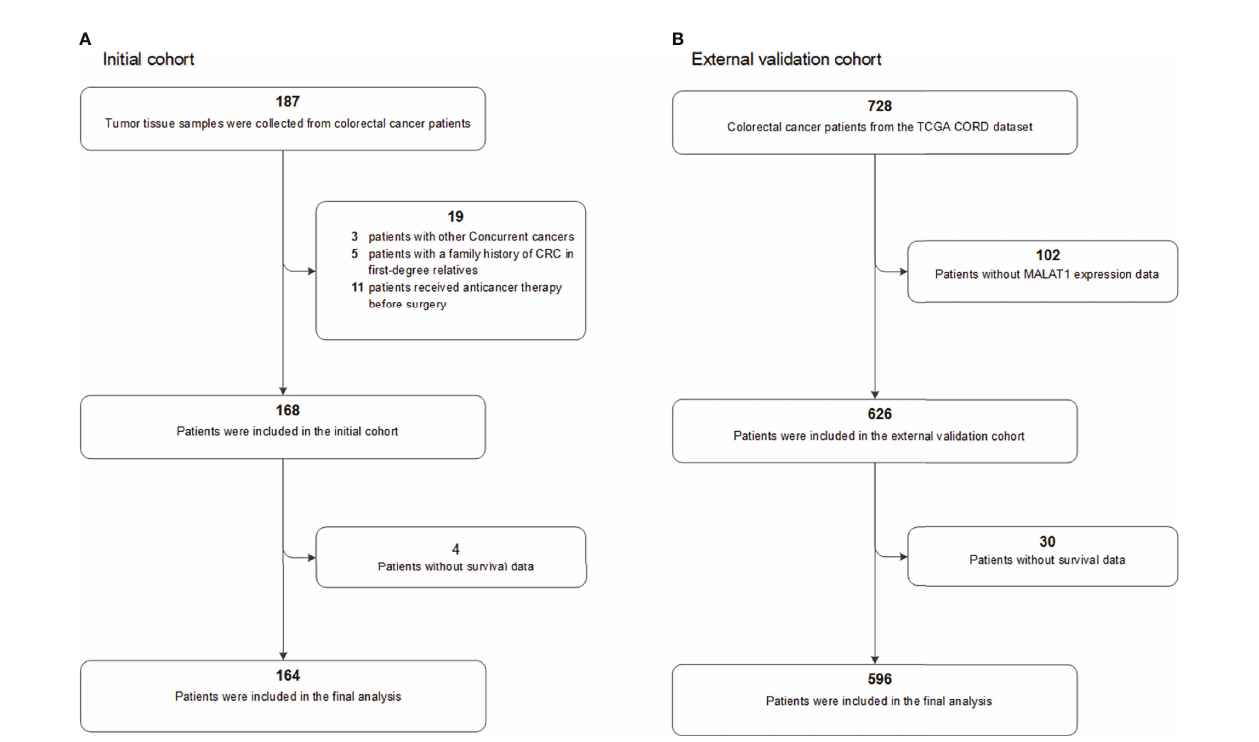
FIGURE 1 | Flow chart of participants included and analysed in the (A) initial and (B) external validation cohorts. COAD, colon adenocarcinoma; CRC, colorectal cancer; TCGA, The Cancer Genome